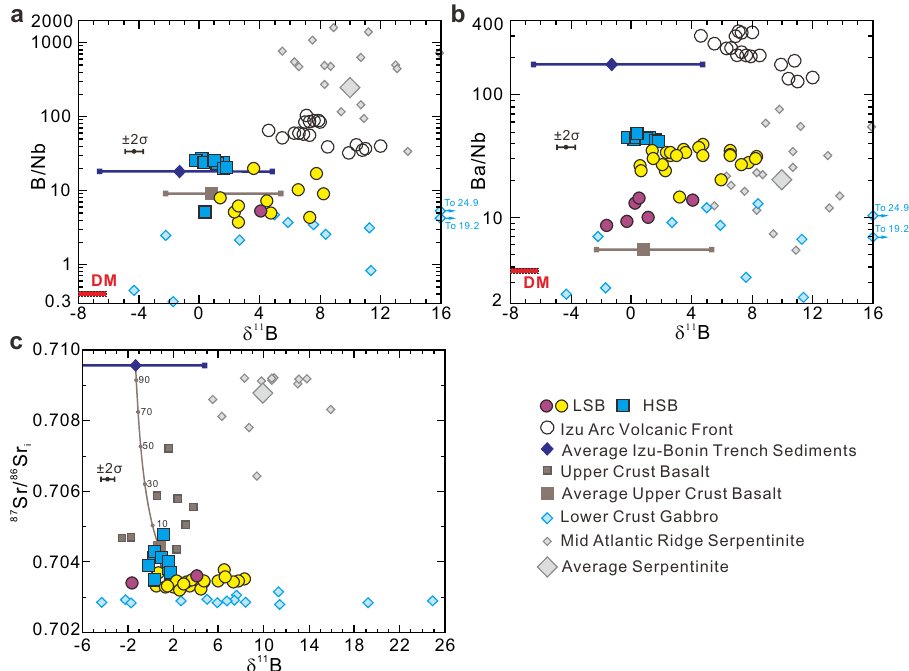
Fig. 3 Boron and strontium isotopes and trace element systematics of the Expedition 352 boninites. Plots of a B/Nb, b Ba/Nb and c 87 Sr/ 86 Sr i vs. δ 11 B for the International Ocean Discovery Program Expedition 352 boninites. Error bars (2 σ = 0.6 ‰ ) for boninite δ 11 B represent average whole chemical process external reproducibility based on duplicate analyses of different digestion of the reference materials and natural samples 62 . Depleted mid-ocean ridge basalt mantle (DM 32,49,64 ), Mid-Atlantic Ridge serpentinites 65 , Izu-Bonin trench sediment 28,38,39 , upper crust basalts (Deep Sea Drilling Project Holes 417A, 417D and 418A) 28,66 , lower crust gabbros (Ocean Drilling Program Hole 735B) 28,54 , and Izu arc (Ocean Drilling Program Hole 782A tephra) 21 data are shown for comparison. Bulk mixing curve between Izu-Bonin trench sediment and upper crust basalt in c is calculated per their chemical compositions, summarized in Supplementary Table 1. Numbers on the mixing curves denote percentages. Two low-silica boninite (LSB) subgroups are distinguished by their distinct Ba versus Nb, Zr, Hf, and Th correlations (Supplementary Fig. 1). HSB: high-silica Slab sources for boninite boron in subduction initiation set-